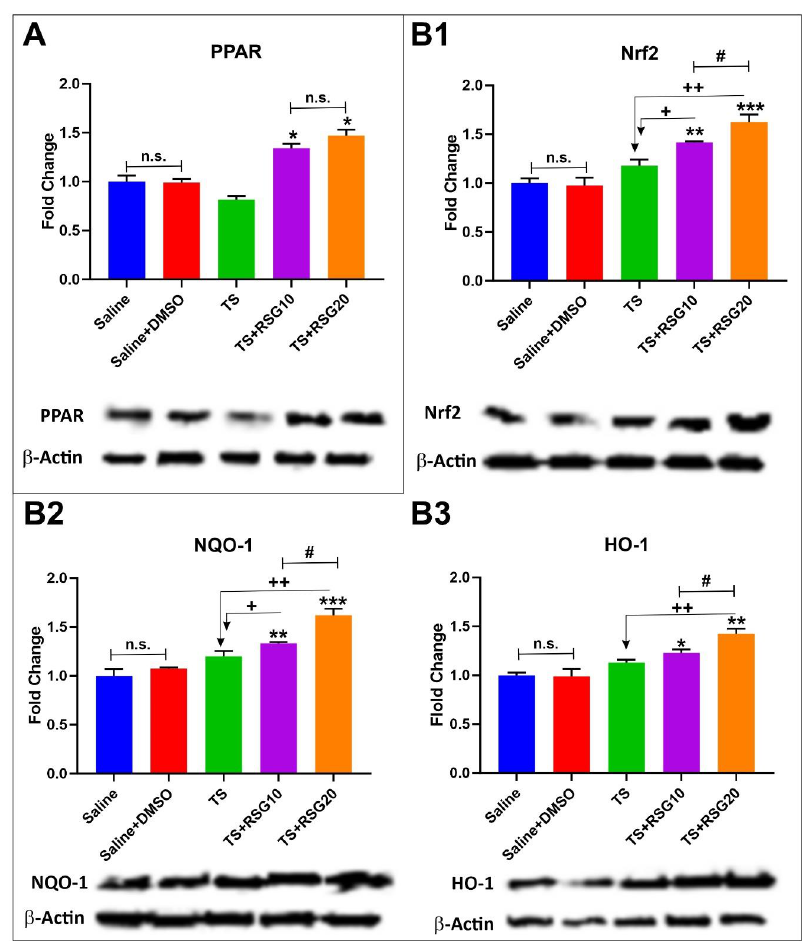
Figure 3. Dose-dependent protective effects of RSG against TS-induced oxidative stress. ( A ) Western blotting analysis emphasizing the effect of RSG on activation of the transcription factor peroxisome proliferator-activated receptor (PPARγ). ( B1 ) Western-blot analysis emphasizing activation of the Nrf2 pathway. ( B2 , B3 ) Parallel to the increased Nrf2 expression levels by RSG, we also observe comparable upregulation of downstream detoxifying molecules NQO-1 and HO-1. n = 4 biological replicates. * p < 0.05, ** p < 0.01, and *** p < 0.001 versus saline. + p < 0.05, ++ p < 0.01, versus TS. # p < 0.05 TS + RSG 20 versus TS + RSG 10. WB analyses report protein / β -actin ratios. n.s. = non statistical